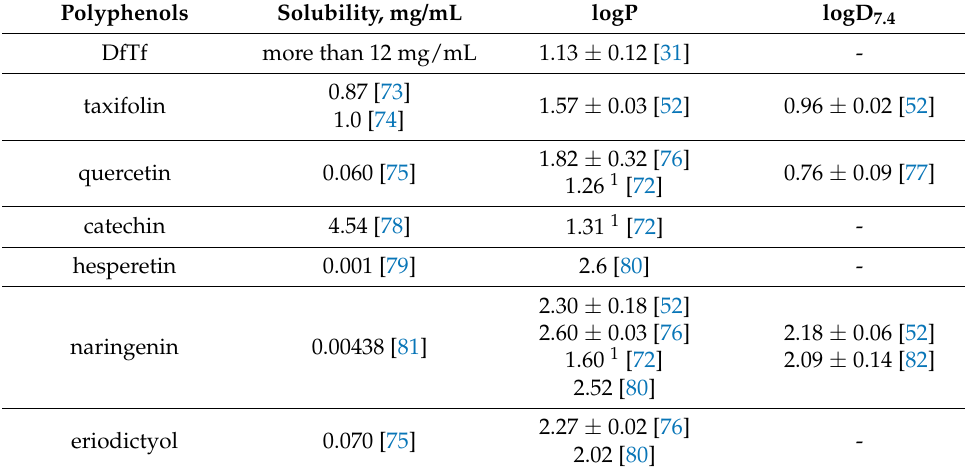
Table 2. Physicochemical parameters of polyphenols being